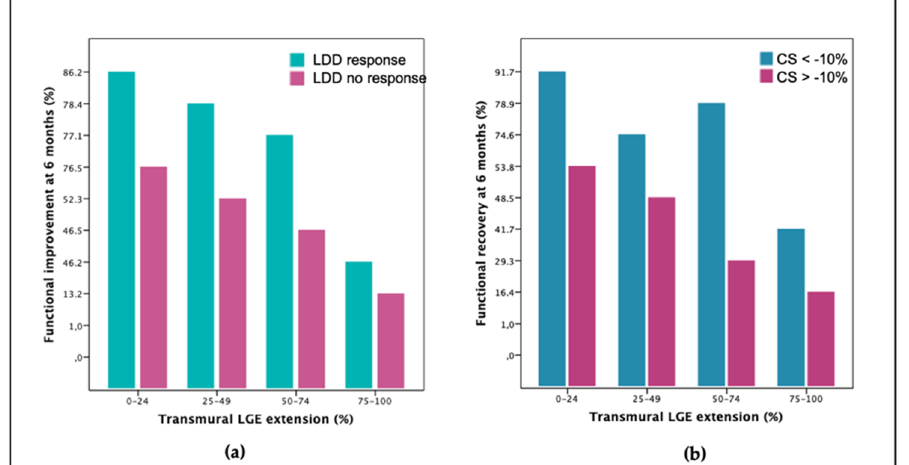
Figure 3. ROC curve analysis for prediction of functional recovery comparing LGE transmurality, CS and the combination of LGE plus CS and LGE plus LDDSE. CS, circumferential strain. LDDSE, low dose dobutamine stress echocardiography. LGE, late gadolinium enhancement transmurality.